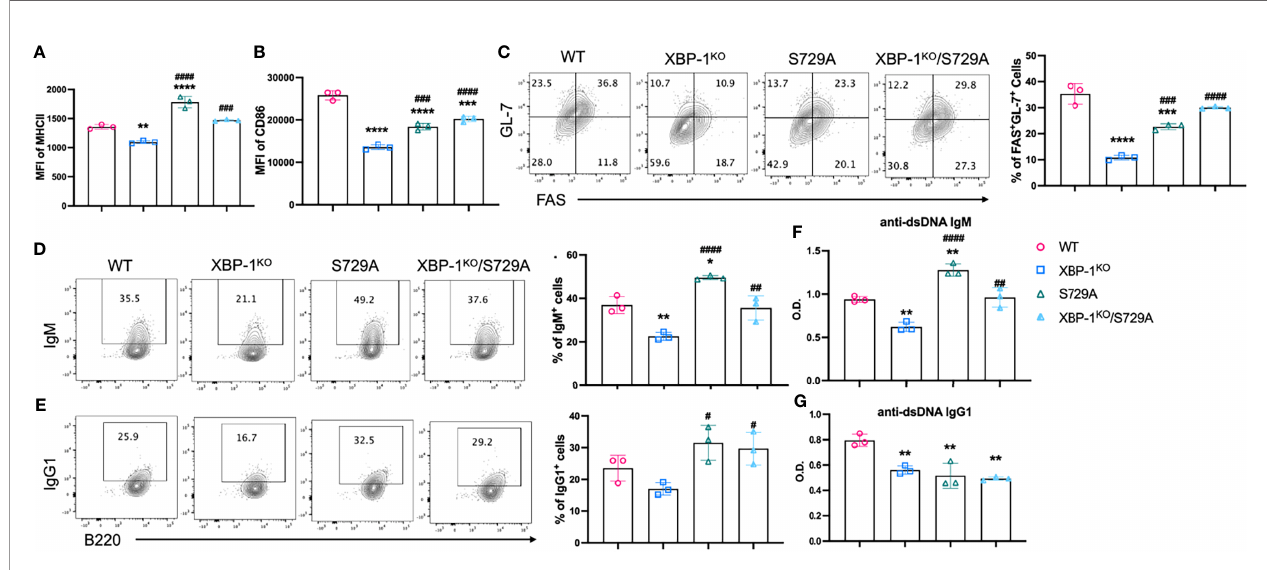
FIGURE 6 | Roles of XBP-1s and the S729A mutation of IRE-1 a in B cell activation, differentiation, and IgM production in vitro . B cells were isolated from WT, XBP- 1 KO , S729A, and XBP-1 KO /S729A mice and stimulated with anti-IgM F(ab ’ )2 (10 mu;g/ml) and anti-CD40 (10 mu;g/ml) for 48 hrs. The expression of MHCII (A) and CD86 (B) were detected by fl ow cytometry. The percentages of germinal center B cells (FAS + GL-7 + ) were presented (C) . (D, E) B cells were stimulated with PMA and Ionomycin for 4 hrs on day 4. Intracellular levels of IgM (D) and IgG1 (E) were detected by fl ow cytometry analysis. Cell culture media were also collected, and anti- dsDNA autoantibodies were detected using ELISA (F, G) . Statistics were performed using two-way ANOVA with Tukey ’ s multiple comparison test. *p < 0.05, **p < 0.005, ***p < 0.0005, and ****p < 0.0001 when compared to WT. # p < 0.05, ## p <0.005, ### p < 0.0005, and #### p < 0.0001 when compared to XBP-1 KO